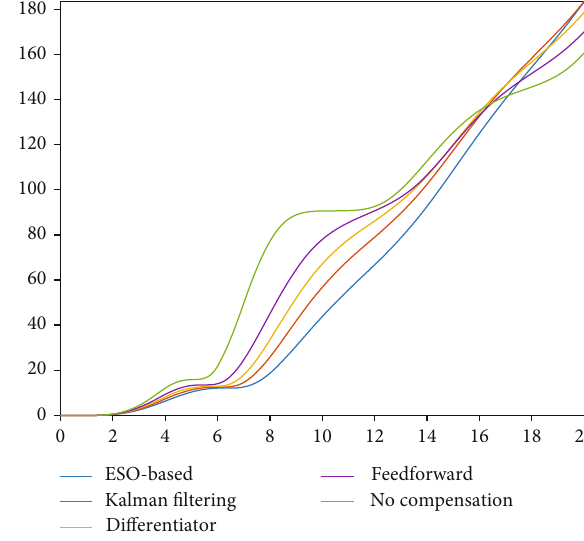
Figure 28: E ff ect of line-of-sight velocity